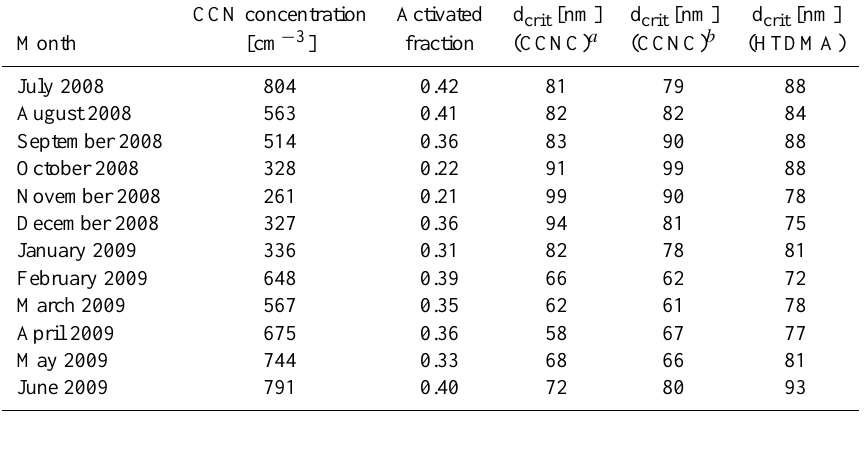
Table 1. Monthly averages of CCN concentration, activated fraction (CCN/CN) and critical diameter, measured at SMEAR II station in Hyyti¨al¨a July 2008–June 2009. Superscripts a and b in CCN derived critical diameters represent averages calculated from all the available data ( a) and from concurrent CCNC data with the HTDMA data ( b) , respectively. The data are for supersaturation of 0.4% representing an average case in the range of measured supersaturations.